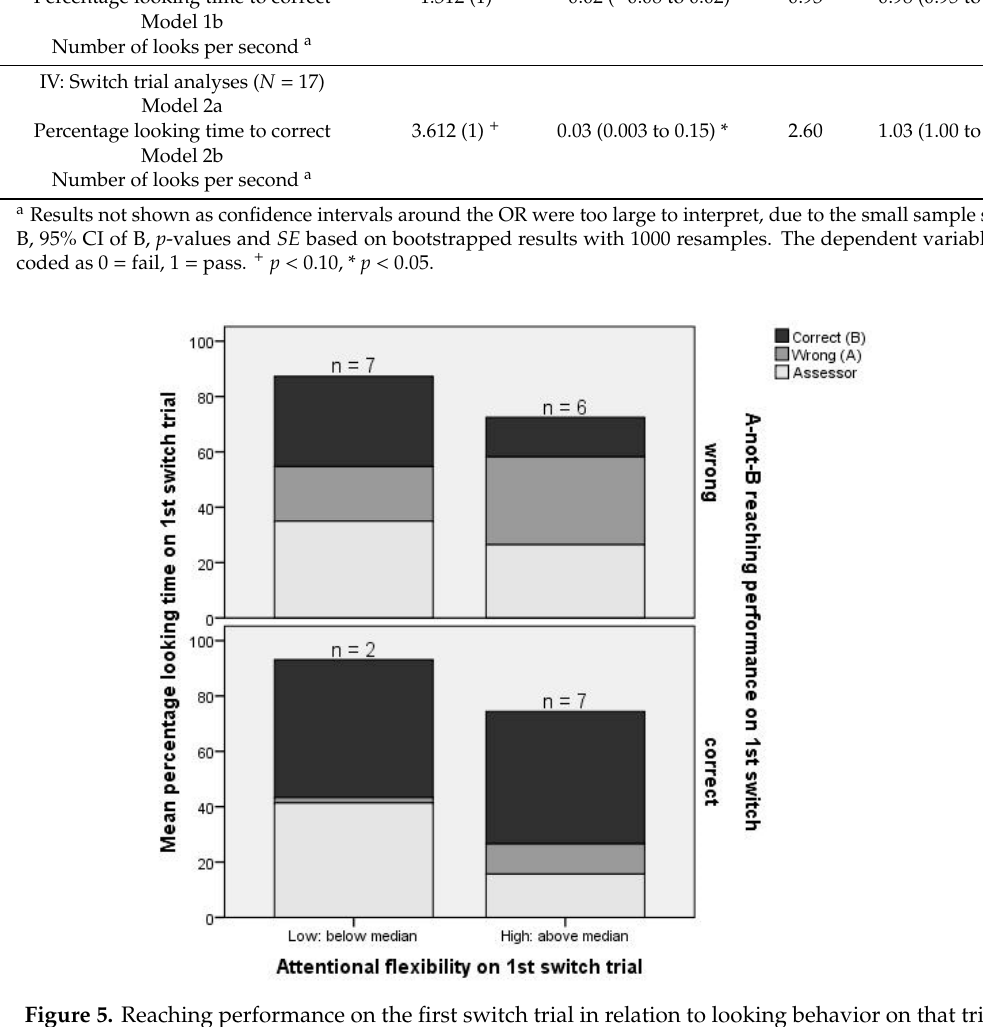
Percentage looking time to the correct location and number of looks per second on the pre-switch and switch trial were entered as predictors of task performance (reaching measure; total number of switches correct) in univariate linear regression. Only the number of looks per second on the pre- switch trial was a consistent positive and significant predictor of reaching performance (Table 4, Model 3b; Figure 6). Thus, children who had more flexible attention just before the first switch trial (as indexed by more looks per second) showed a greater level of flexibility in their subsequent manual responses (as indicated by these children being more likely to pass a greater number of switch trials in total). (The sample size for analysis was N = 23 for pre-switch IVs and N = 22 for switch IVs, given that one child had missing eye tracking data on the switch trial. When this child was also excluded from the analyses with pre-switch IVs ( N = 22), results were comparable to those shown in Tables 3 and 4 (ORs did not change, β s changed by no more than 0.01)). Note that our measure of focused attention included also looks to the hand of the experimenter holding the hiding screen in front of the correct location (see also Figure 1D) and looks to a part of the child him/herself in front of the hiding location (i.e., the hand). When these looks were excluded from the focused attention measure, results were comparable to those shown in Tables 3 and 4 (ORs changed by no more than 0.01, β s changed by no more than 0.02). Table 4. Results of univariate linear regression analyses predicting total number of switches correct. R 2